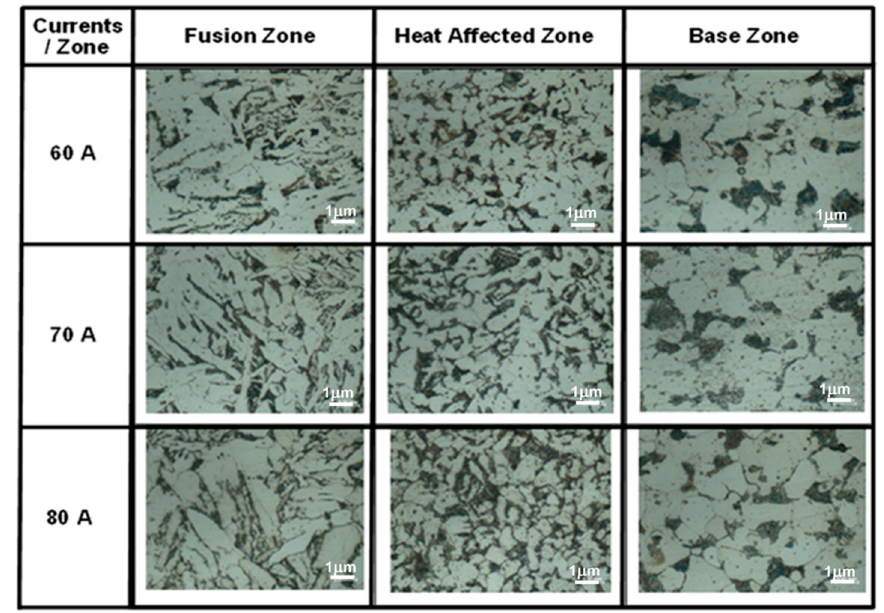
Figure 4. Microstructure of specimens obtained from welding current at 60, 70 and 80 A .